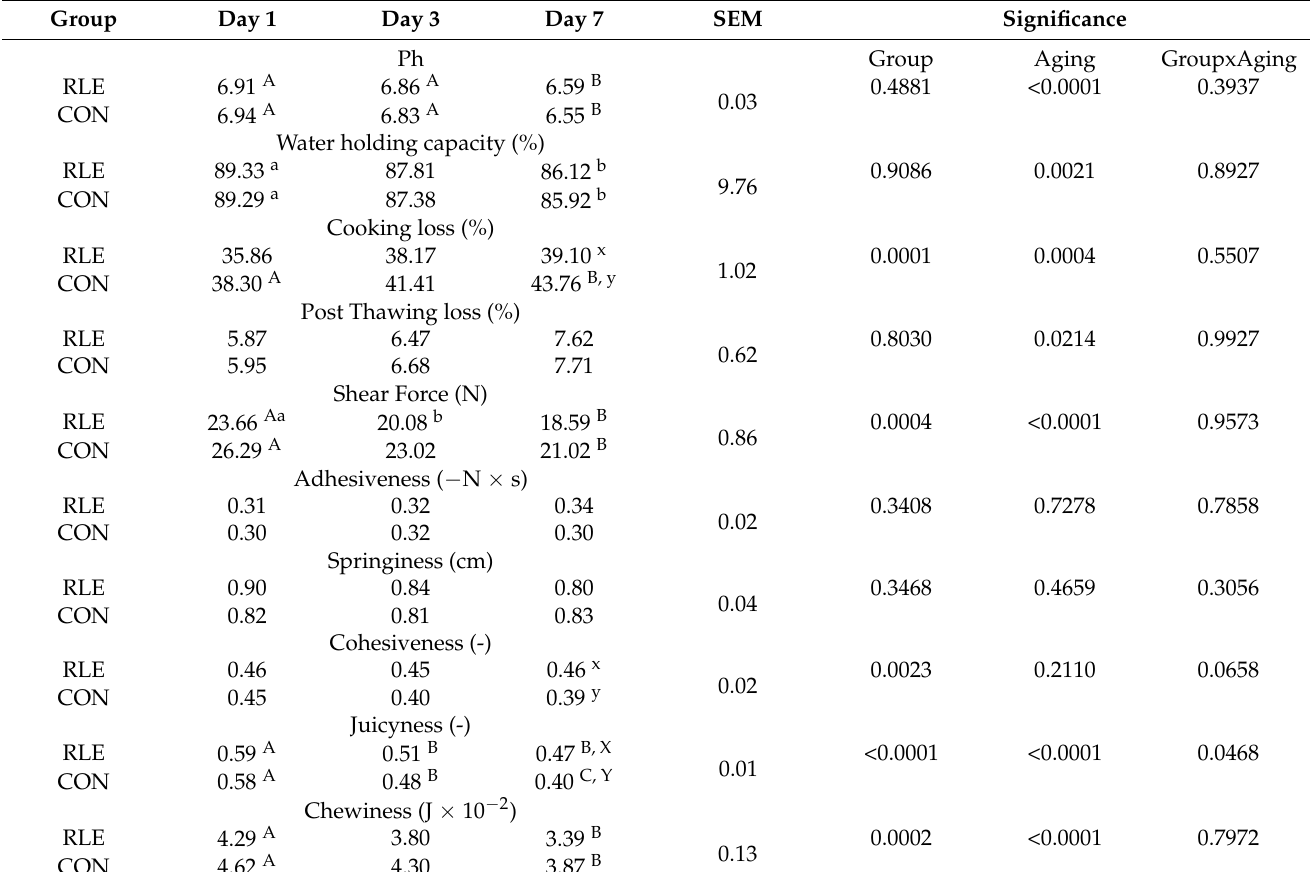
Table 4. Effect of including anthocyanins in the diet and of aging time on kid’s meat rheological parameters and texture profile analysis. Group RLE (RLE treated group); Group CON